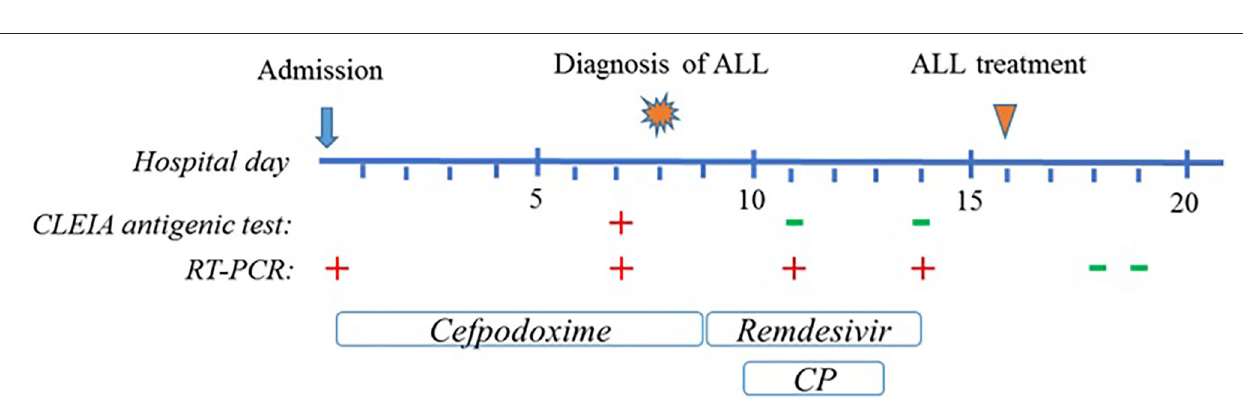
use of CP in the pediatric population with severe Covid-19 and/or immunodeficiency with concomitant SARS-CoV-2 infection. All resulted in good outcomes and no adverse events (11, 16,